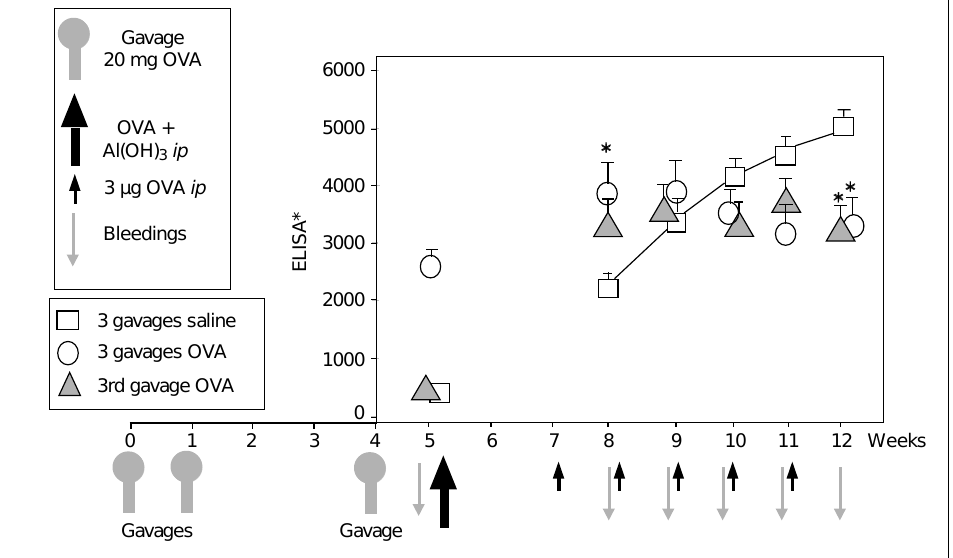
Figure 1 - Stabilization of anti- OVA antibody production in orally immunized mice. Control mice (squares) received 3